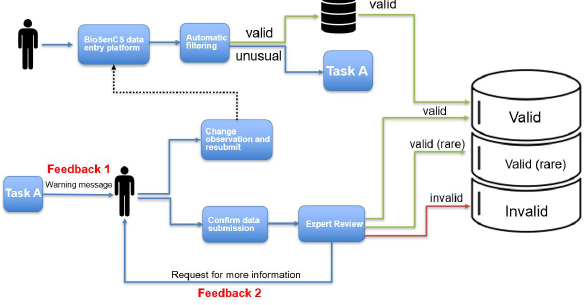
Figure 2. The automatic data validation procedure applied in